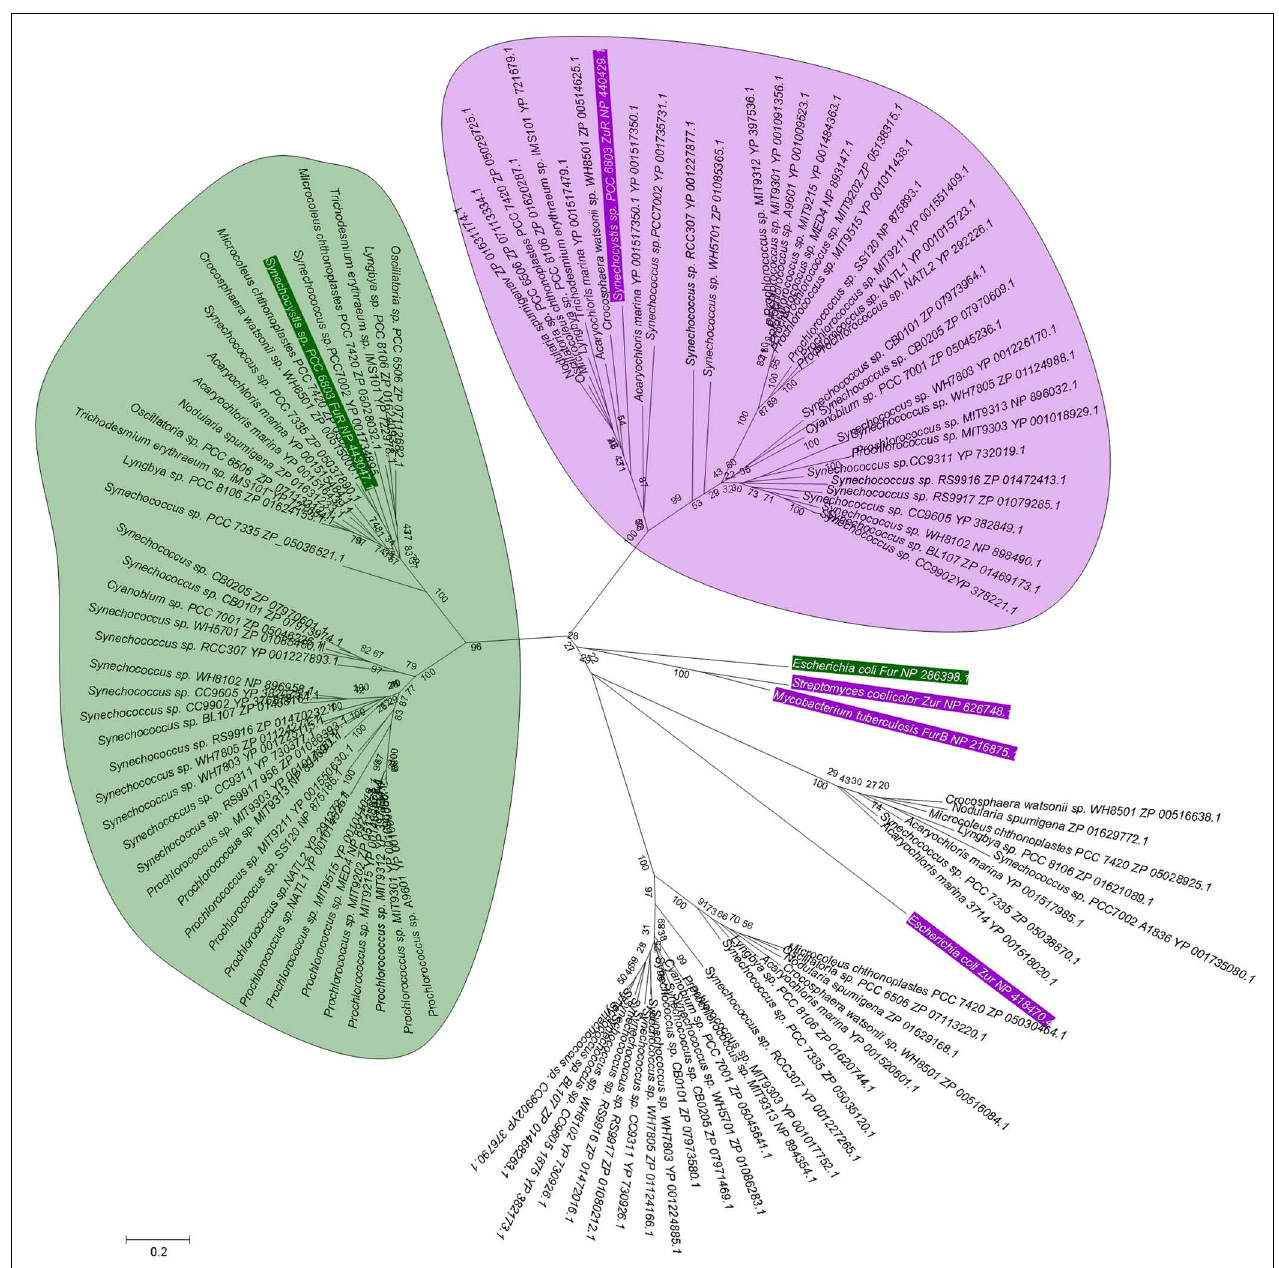
and manually edited prior to import into MEGA5 (Tamura et al., 2011). Phylogeny was inferred using the minimal evolution method. Bootstrap values are the result of 1000 replications. Evolutionary distance was estimated using the JTT model of substitution.There are four clear branches. Inclusion of Synechocystis Zur and Fur allows the suggestion that the branches containing these sequences correspond to zinc-responsive (light purple bubble) and iron-responsive (light green bubble) regulators.The Zur and Fur sequences from other bacteria do not cluster with any of the four branches, indicating that similarity between cyanobacterial sequences and those from other bacteria do not allow to infer metal